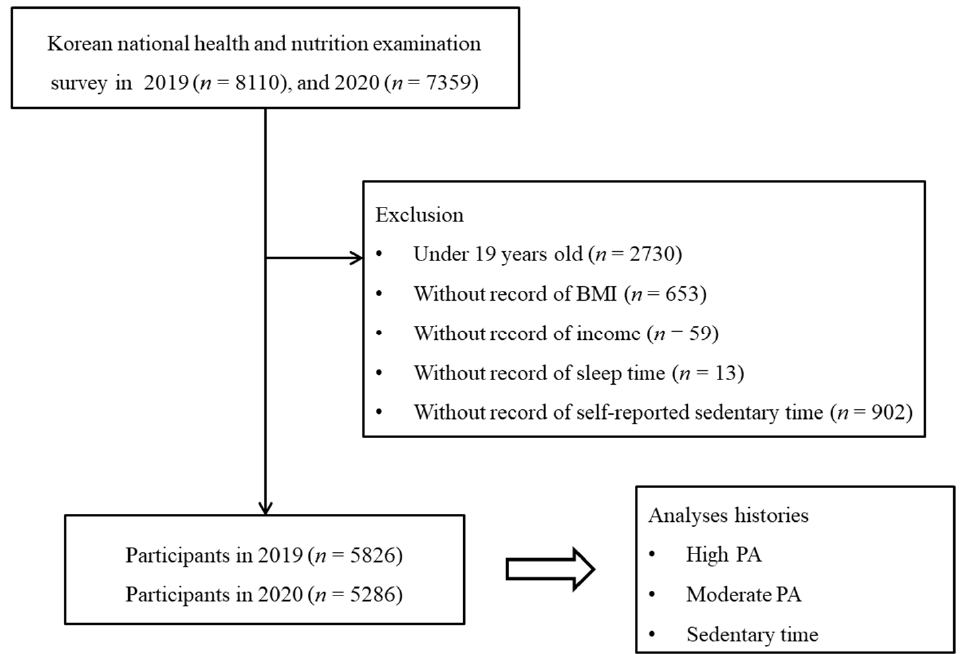
Figure 1. Study design of the present study. From the Korean National Health and Nutritional Examination data, a total of 5826 individuals in the 2019 cohort were compared with 5286 individuals in the 2020 cohort for high-intensity physical activity (PA), moderate PA, and sedentary time. The rates of time spent on high PA and moderate PA in the 2019 and 2020 groups were not different (Table 1). A total of 9.1% of the 2019 group and 8.9% of the 2020 group reported ≥ 75 min/wk of high PA ( p = 0.814). For moderate PA, 14.9% of the 2019 group and 16.7% of the 2020 group described ≥ 150 min/wk of moderate PA ( p = 0.097). Sedentary time was not significantly different between the 2020 group and the 2019 group ( p = 0.071). The odds for ≥ 75 min/wk of high PA were not decreased in the 2020 group compared to the 2019 group (adjusted OR (aOR) = 0.96, 95% CI = 0.79–1.18, p = 0.696, Table 2). The results on the association of ≥ 75 min/wk of high PA with the 2020 group were consistent in all age and sex subgroups (all p >